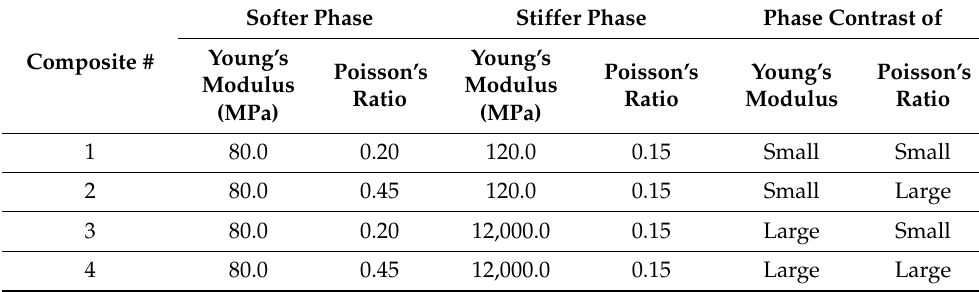
Table 3. Two-phase composites with different contrasts of phase